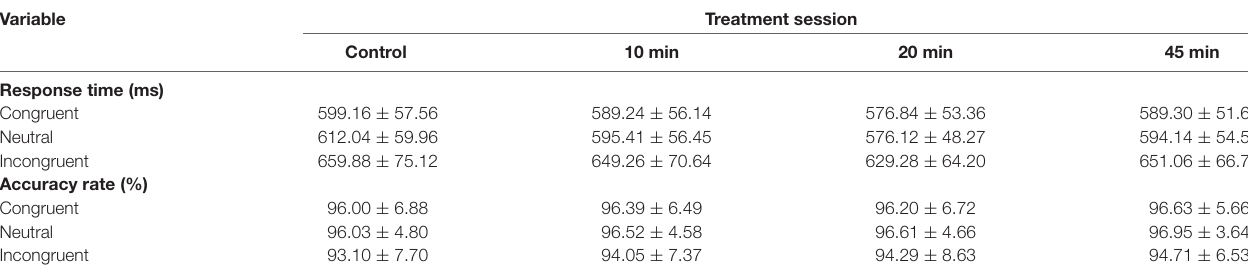
TABLE 3 | Response time and accuracy rate for stroop test following the exercise sessions (M ±